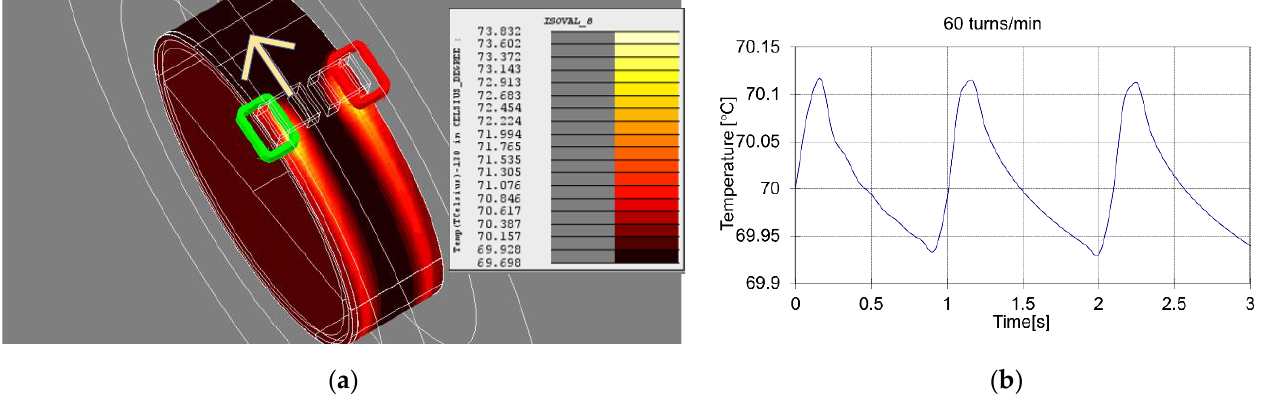
Figure 10. Results of thermal calculations for several cylinder shifts ( a ); temperature fluctuations under the inductor for three turns of the cylinder with a rotational speed of one turn per second ( b ).